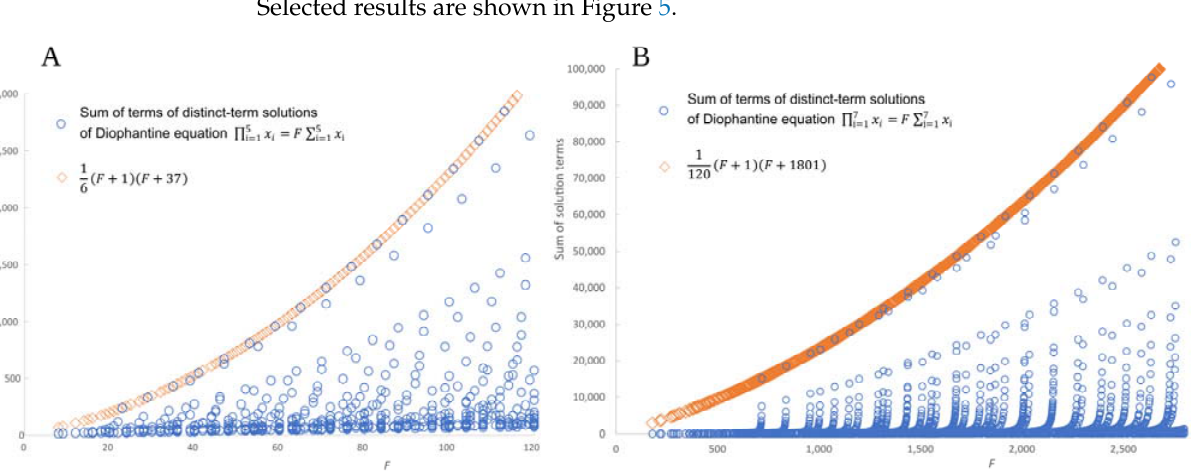
Figure 5. Sums of solution terms of Diophantine equation ∏ n i = 1 x i = F ∑ n i = 1 x i with x i , F ∈ Z + for solutions consisting of distinct terms, plotted with conjectured upper bounds. ( A ): n = 5; ( B ): n =